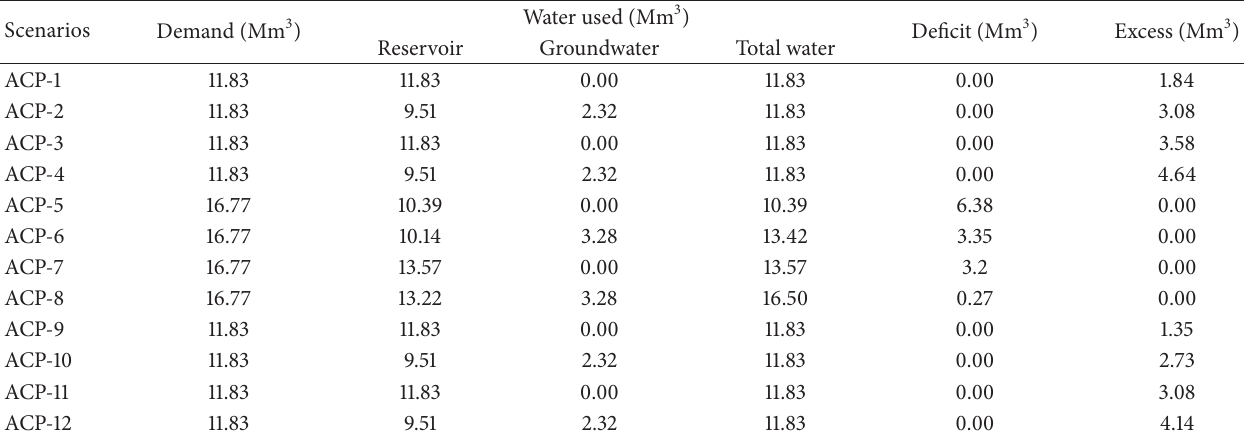
Table 5: Irrigation demand, water used, and deficit from MIKE BASIN results in